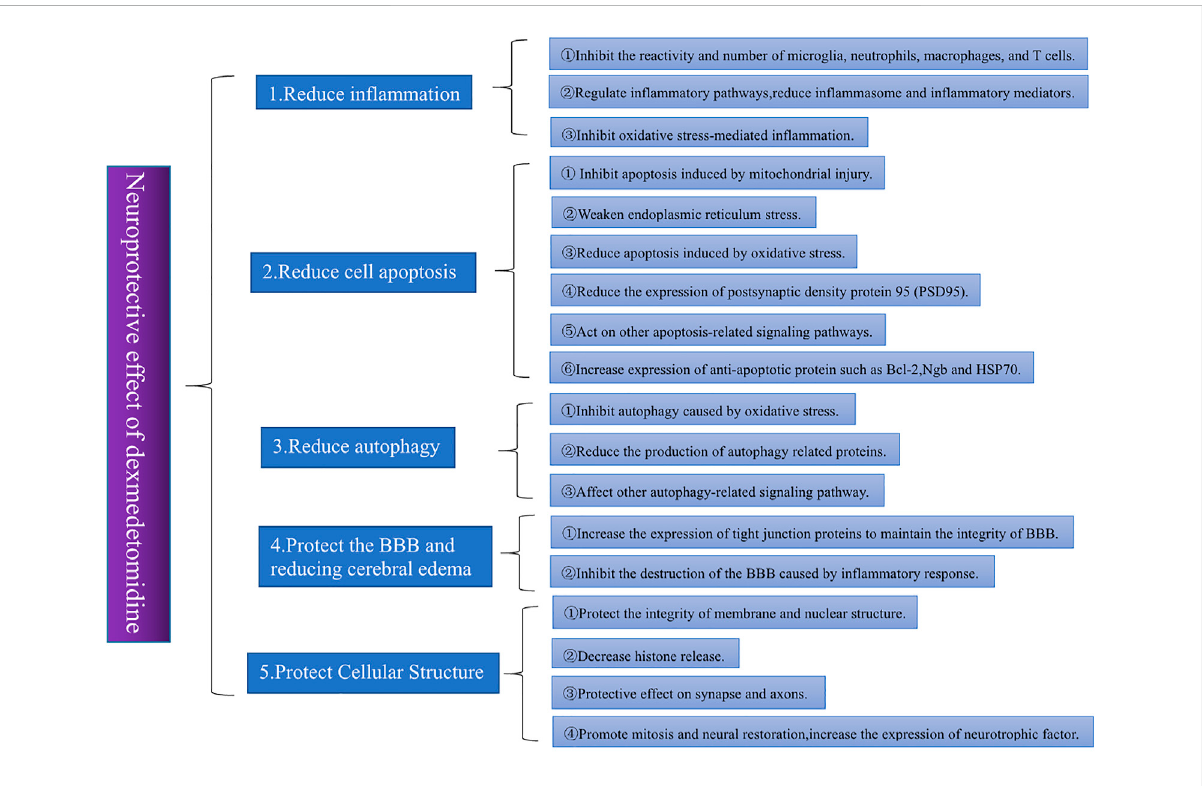
FIGURE 1 Different trials often offer different explanations for the neuroprotective effects of DEX. By sorting and summarizing relevant studies in recent years, we found that the neuroprotective effects of DEX are mainly re fl ected in fi ve aspects: 1) reducing in fl ammation, 2) reducing apoptosis, 3) reducing autophagy, 4) protecting the BBB and reducing cerebral edema, and 5) protecting the cellular structure. Among these aspects, the reductionofthein fl ammatoryresponseisthemostimportant.AlmostallstudiesontheneuroprotectiveeffectofDEXinvolvetheimprovement of nervous system in fl